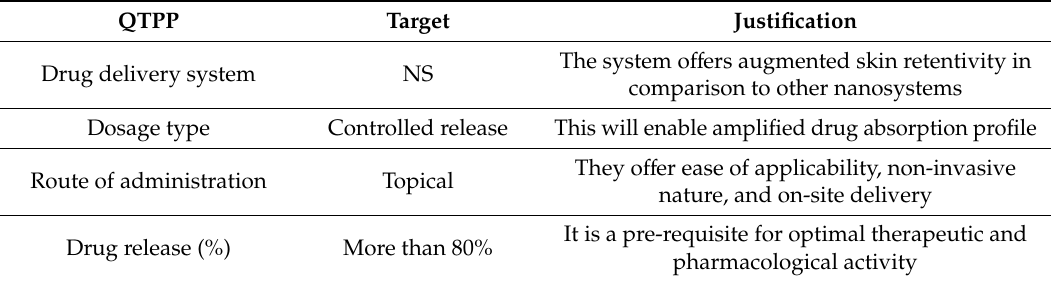
Table 1. QTPP with its target and justification for the fabrication of